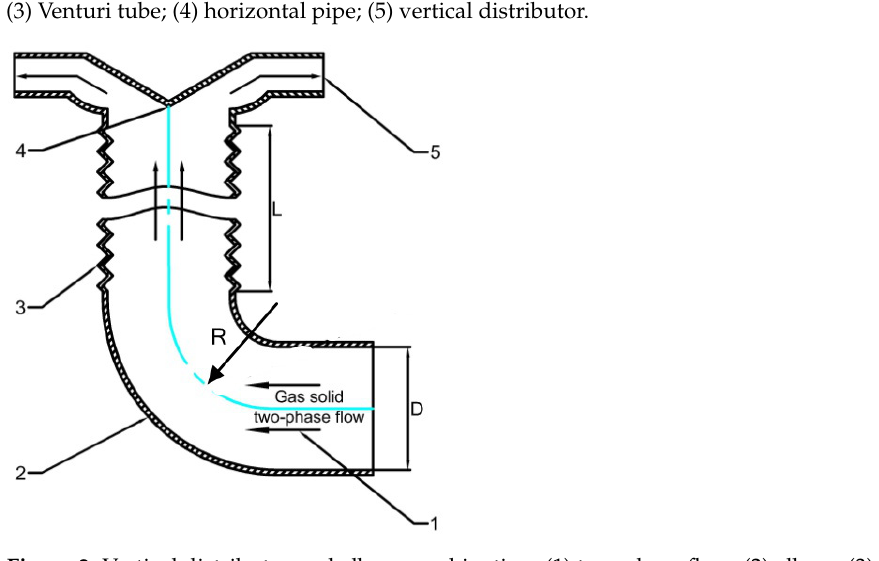
Figure 2. Vertical distributor and elbow combination. (1) two-phase flow; (2) elbow; (3) corrugated pipe; (4) top cover; (5) discharge pipe; (4) top cover; (5) discharge outlet.